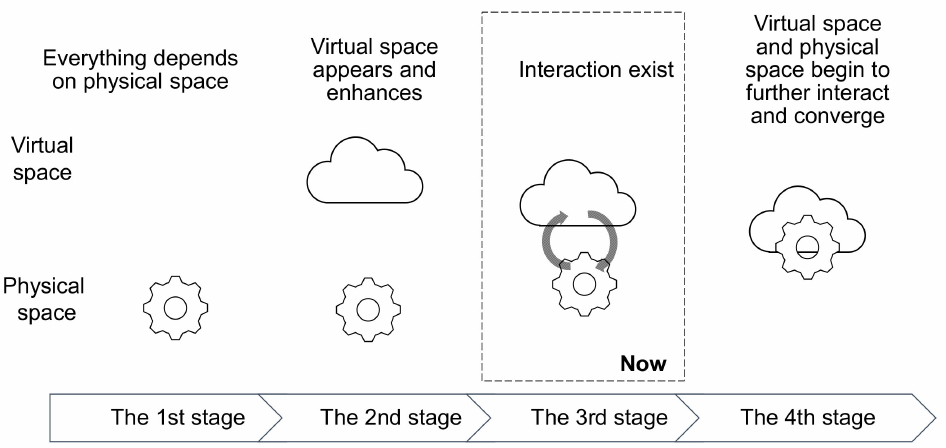
Figure 1. Convergence of shop floor. Source: